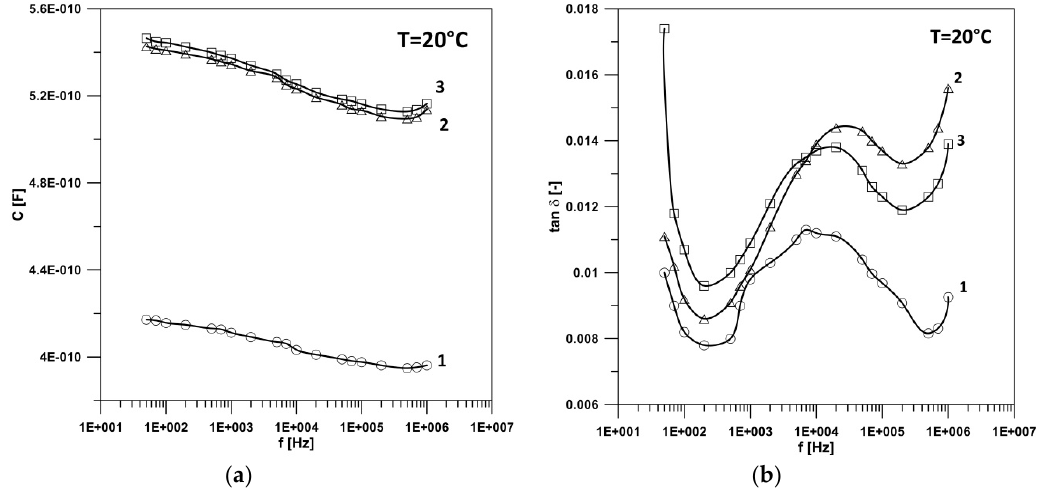
Figure 6. The influence of the impregnating liquid type on the characteristics of capacitance C ( a ) and loss factor tan δ ( b ) of the non-aged aramid insulation samples: 1—mineral oil, 2—synthetic ester, 3—natural ester.